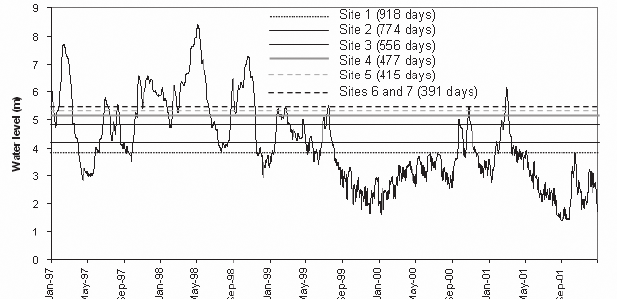
Fig. 2. Water level fluctuations of the Paraná River at Corrientes between 1997 and 2001. The Sites were connected with the Paraná River above the hydrological level indicated by the horizontal lines. The number of flooding days (in parentheses) indicates the connectivity between the floodplain and the river